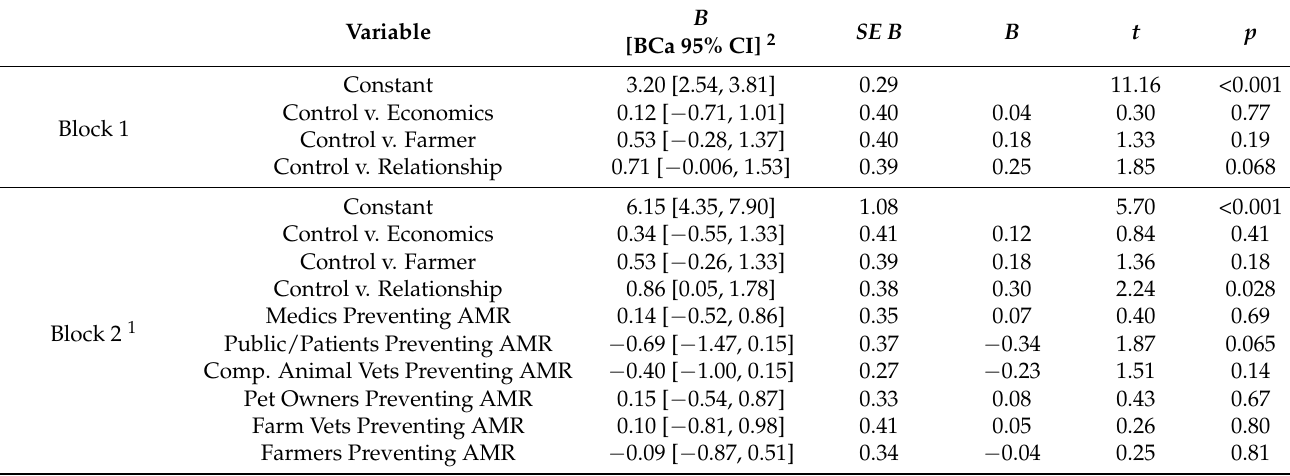
Table 5. Hierarchical Regression Model for Beliefs about Responsibility for Preventing AMR as Predictors of Prescribing.